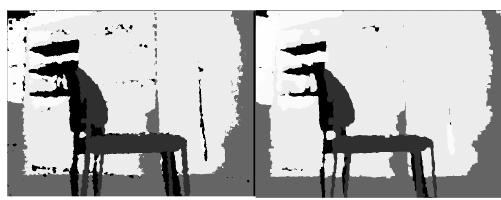
Figure 4. Morphological transformations comparison.